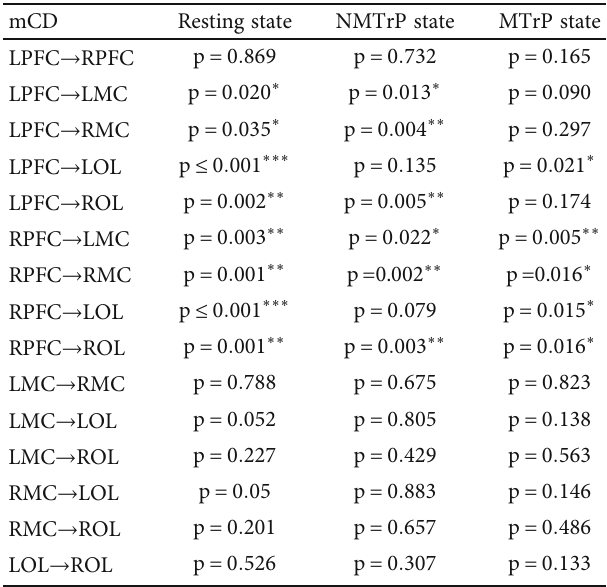
Figure 6: Comparison of region-wise EC among three states in three di ff erent intervals: interval III (a – c), interval IV (d – f), and interval V (g – i). Error bars are mean ± s : e : m : No signi fi cant di ff erence ( p > 0 : 0167 ); ∗ : p < 0 : 0167 . MTrP: myofascial trigger point; NMTrP: nonmyofascial trigger point; L: left; R: right; PFC: prefrontal cortex; MC: motor cortex; OL: occipital lobe. Table 2: Statistical results of mCDs among 6 brain regions in Interval